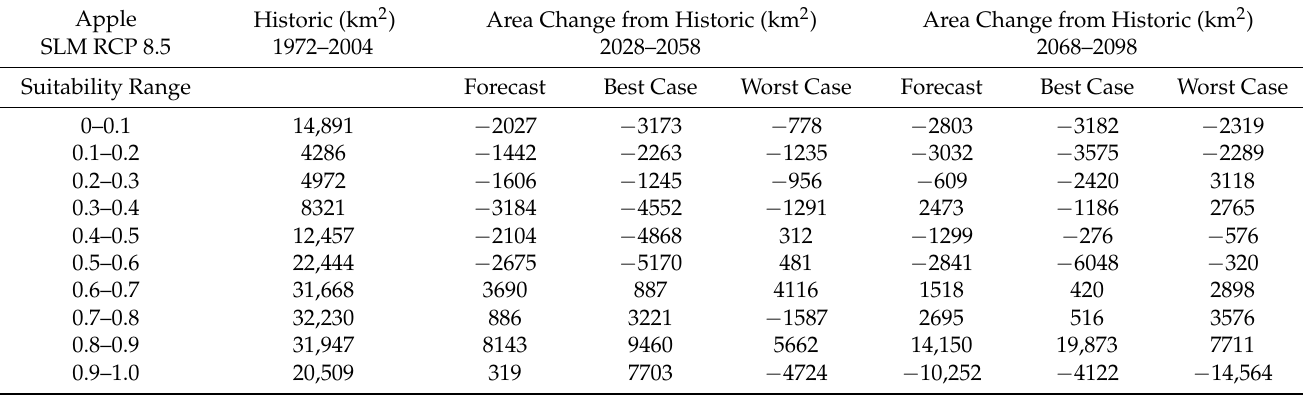
Table A3. Apples: land area in the historic period falling into different cultivation suitability ranges, forecast change for the mid- and late-century under RCP 8.5 and best and worst cases.